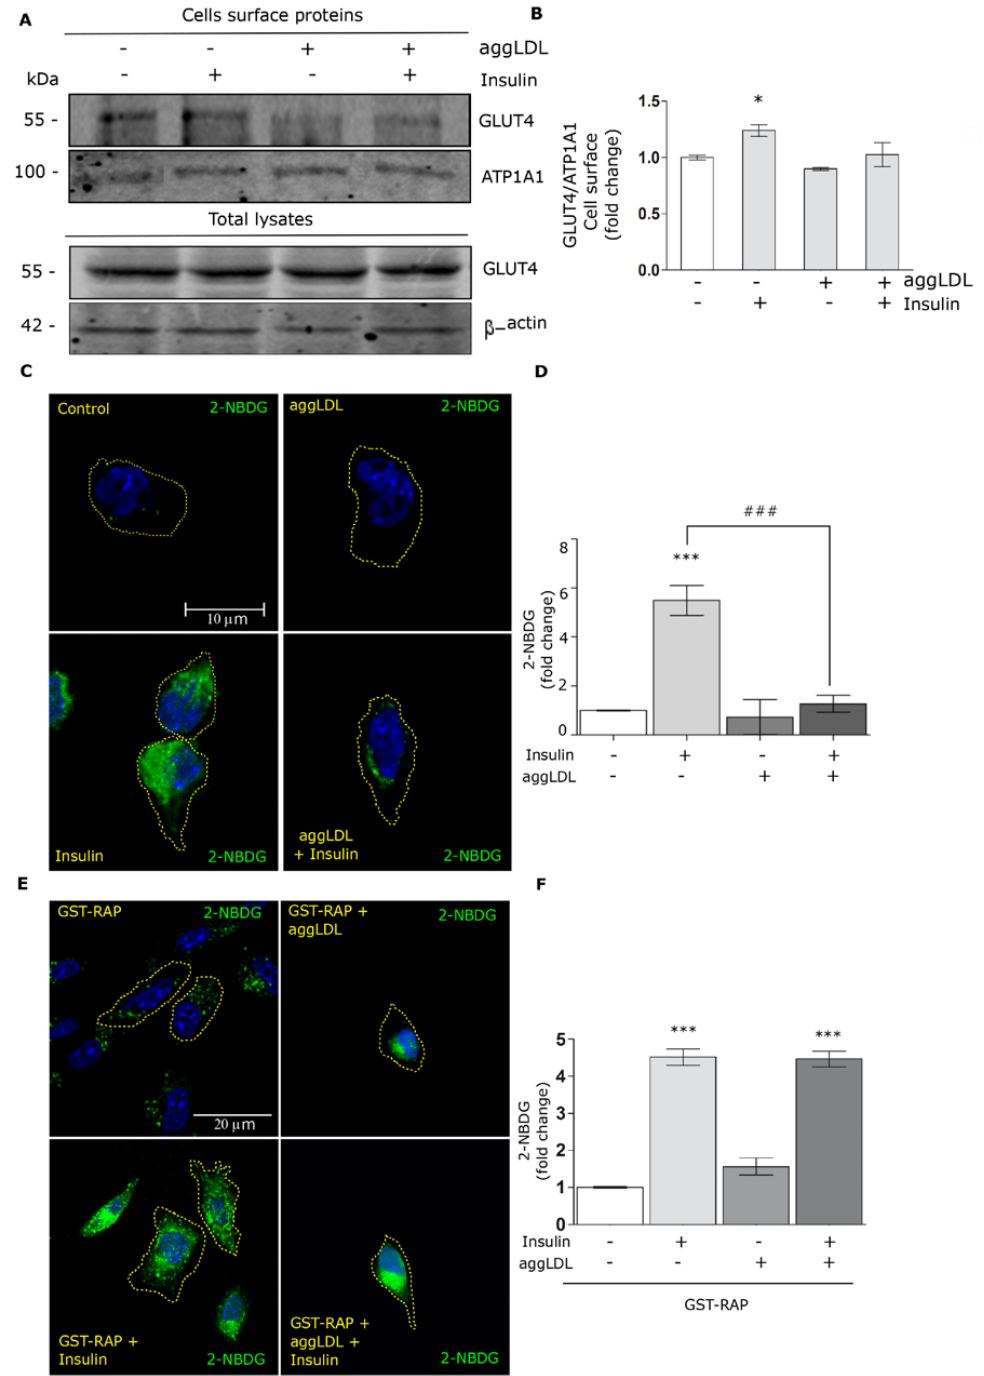
Figure 5. Level of GLUT4 protein in the plasma membrane and 2- NBDG uptake by HL-1 cells treated with aggLDL and insulin. ( A ) Biotinylation assay of surface proteins for the detection of biotinylated GLUT4, from protein extracts after an incubation assay with 100 µg/mL aggLDL for 8 h and subsequent stimulation with 100 nM insulin for 30 min. Next, biotinylated proteins on the cell surface were subsequently isolated by incubation with streptavidin-conjugated beads. The GLUT4 detection in the total cell lysates is shown in the lower panel of the Western blot. ATP1A1 and β -actin were used as protein loading controls, respectively. ( B ) Bar graph represents the mean ± SEM of the relative optical densities (O.D.) (referred to biotin-ATP1A1 as loading control of PM proteins) of the